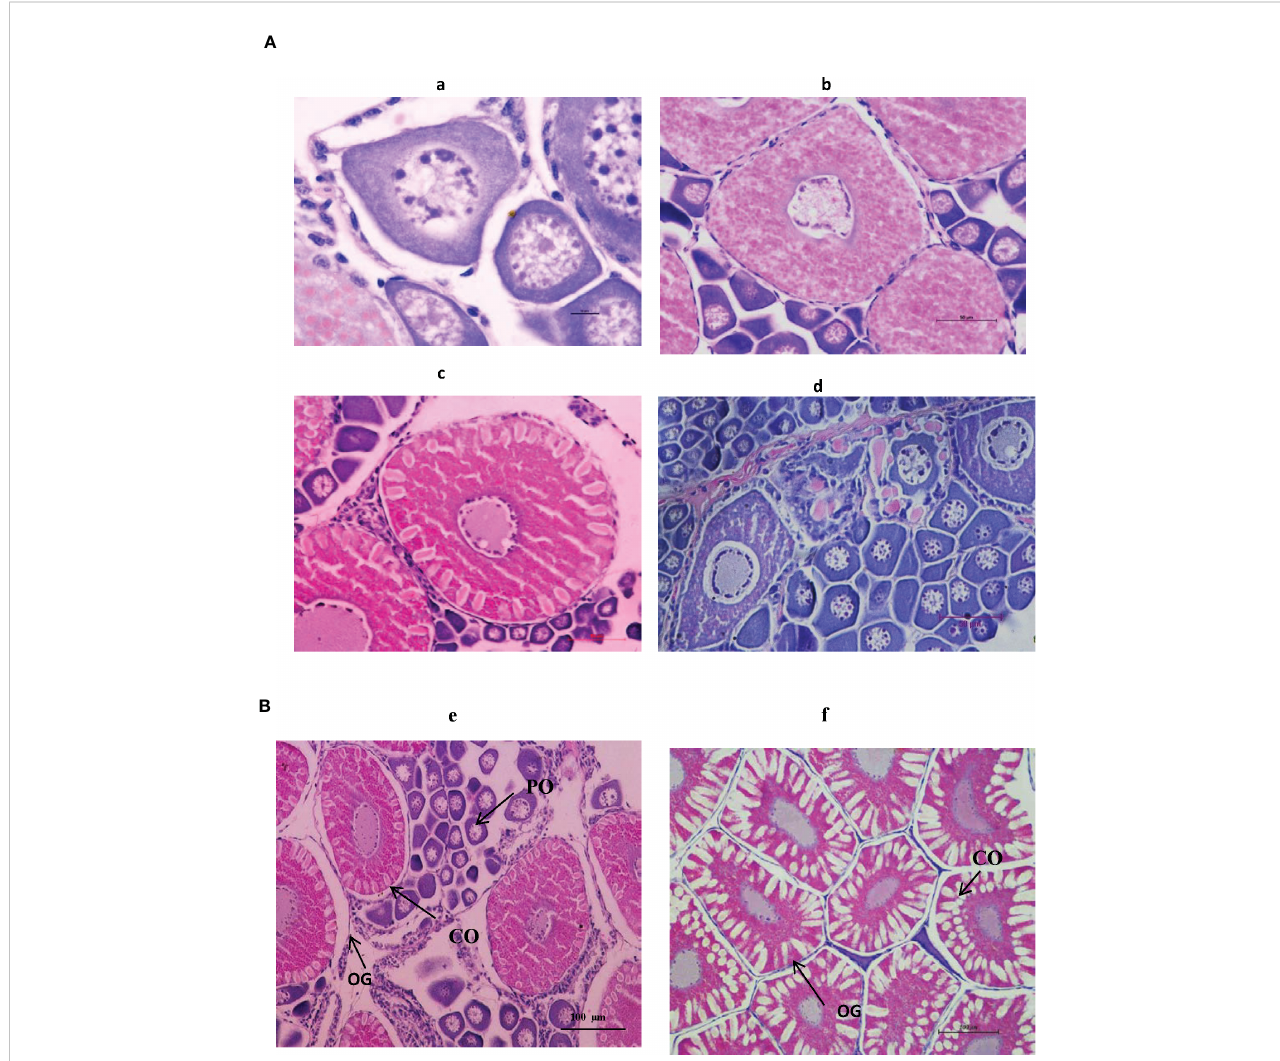
FIGURE 10 (A) The histological architecture of different ovarian stages of captive-reared Indian white shrimp Penaeus indicus. a) . Previtellogenic oocyte (Scale bar: 100 × 10 × objective) b) . Vitellogenic oocyte (Scale bar 40 × 10 × objective) c) . Cortical oocyte (Scale bar 40 × 10 × objective) d) . Spent/atretic oocyte (Scale bar 40 × 10 × objective) (B) . The histological architecture of gravid ovarian stages of Indian white shrimp Penaeus indicus. e) . Captive-reared broodstock f) .Wild broodstock (Scale bar: 20 × 10 × objective) PO, Previtellogenic oocyte; CO, Cortical oocyte; OG, oogonial